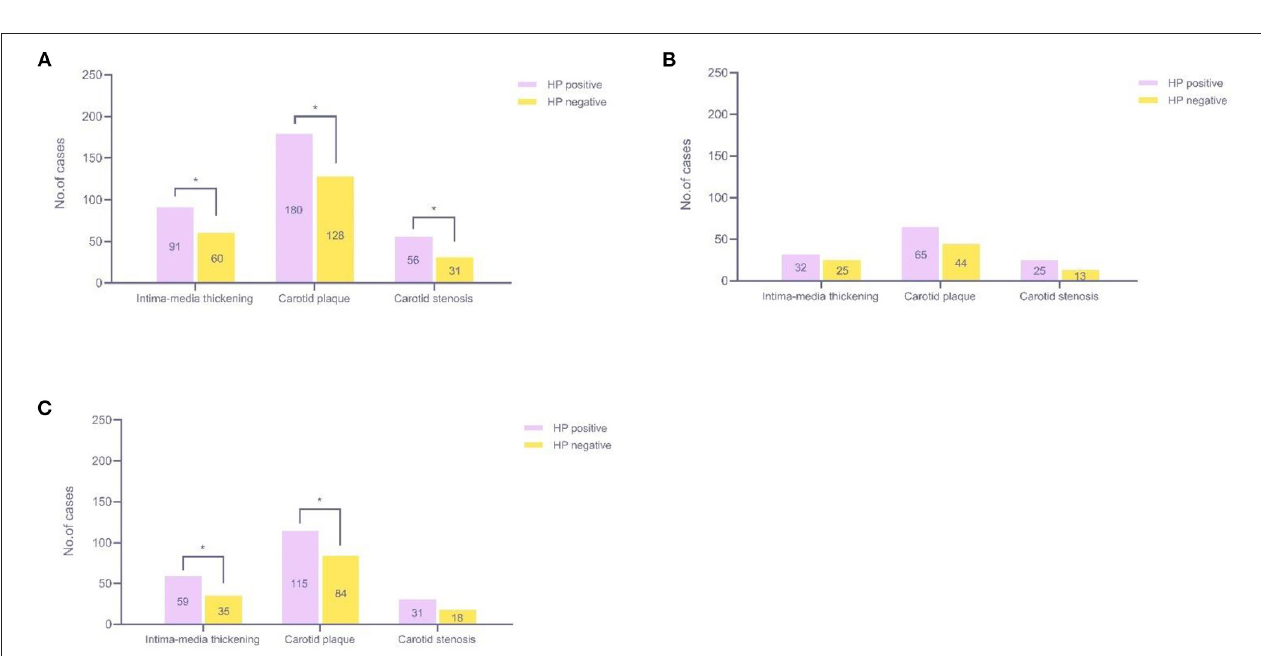
FIGURE 5 | Relationship among the three types of CAS and HP infection. (A) All participants (45–81 years old, n = 1,424); (B) Middle-aged participants (45–59 years old, n = 589); (C) Seniors (over 60 years old, n = 835). * P < 0.05. CAS, carotid atherosclerosis; HP, Helicobacter pylori